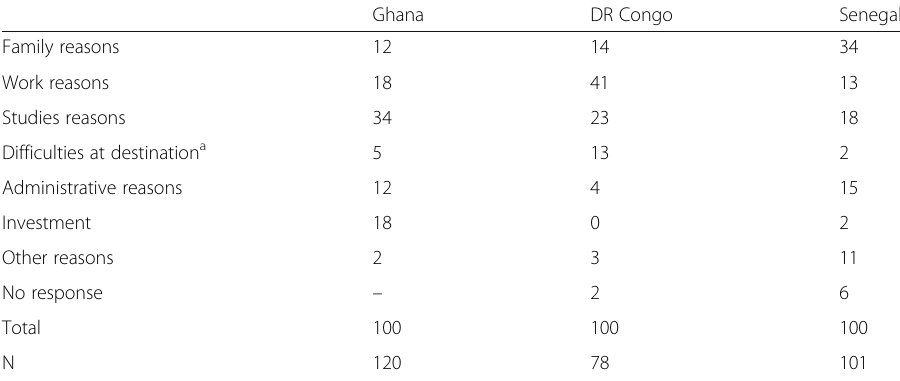
Table 3 Motives of return from Europe by origin (1975 – 2008). Percentage of return